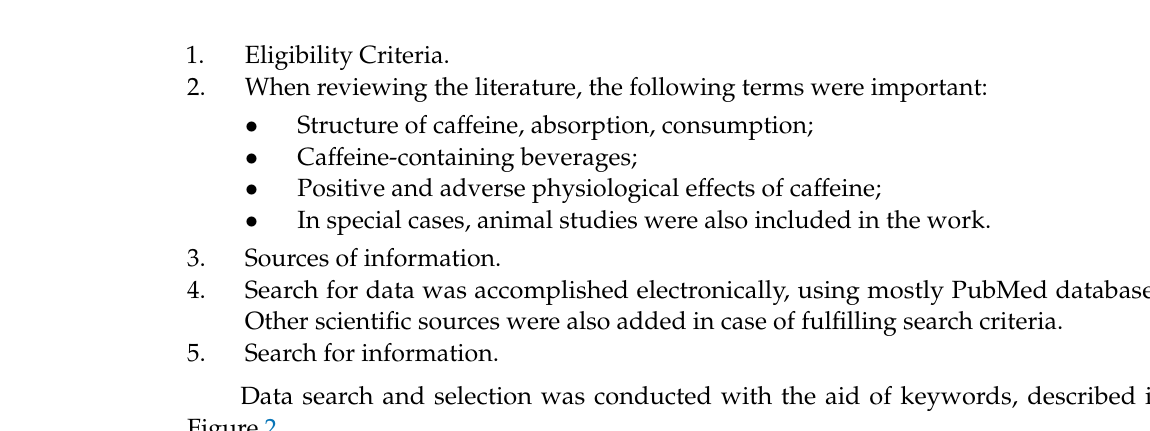
Figure 1. Steps for the review of the literature (Torres et al., 2020) [20].